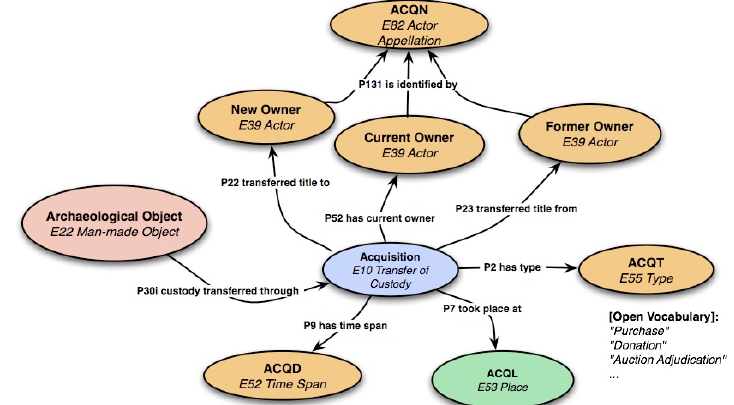
Fig. 3. The Acquisition process and the “ACQ” section of the RA